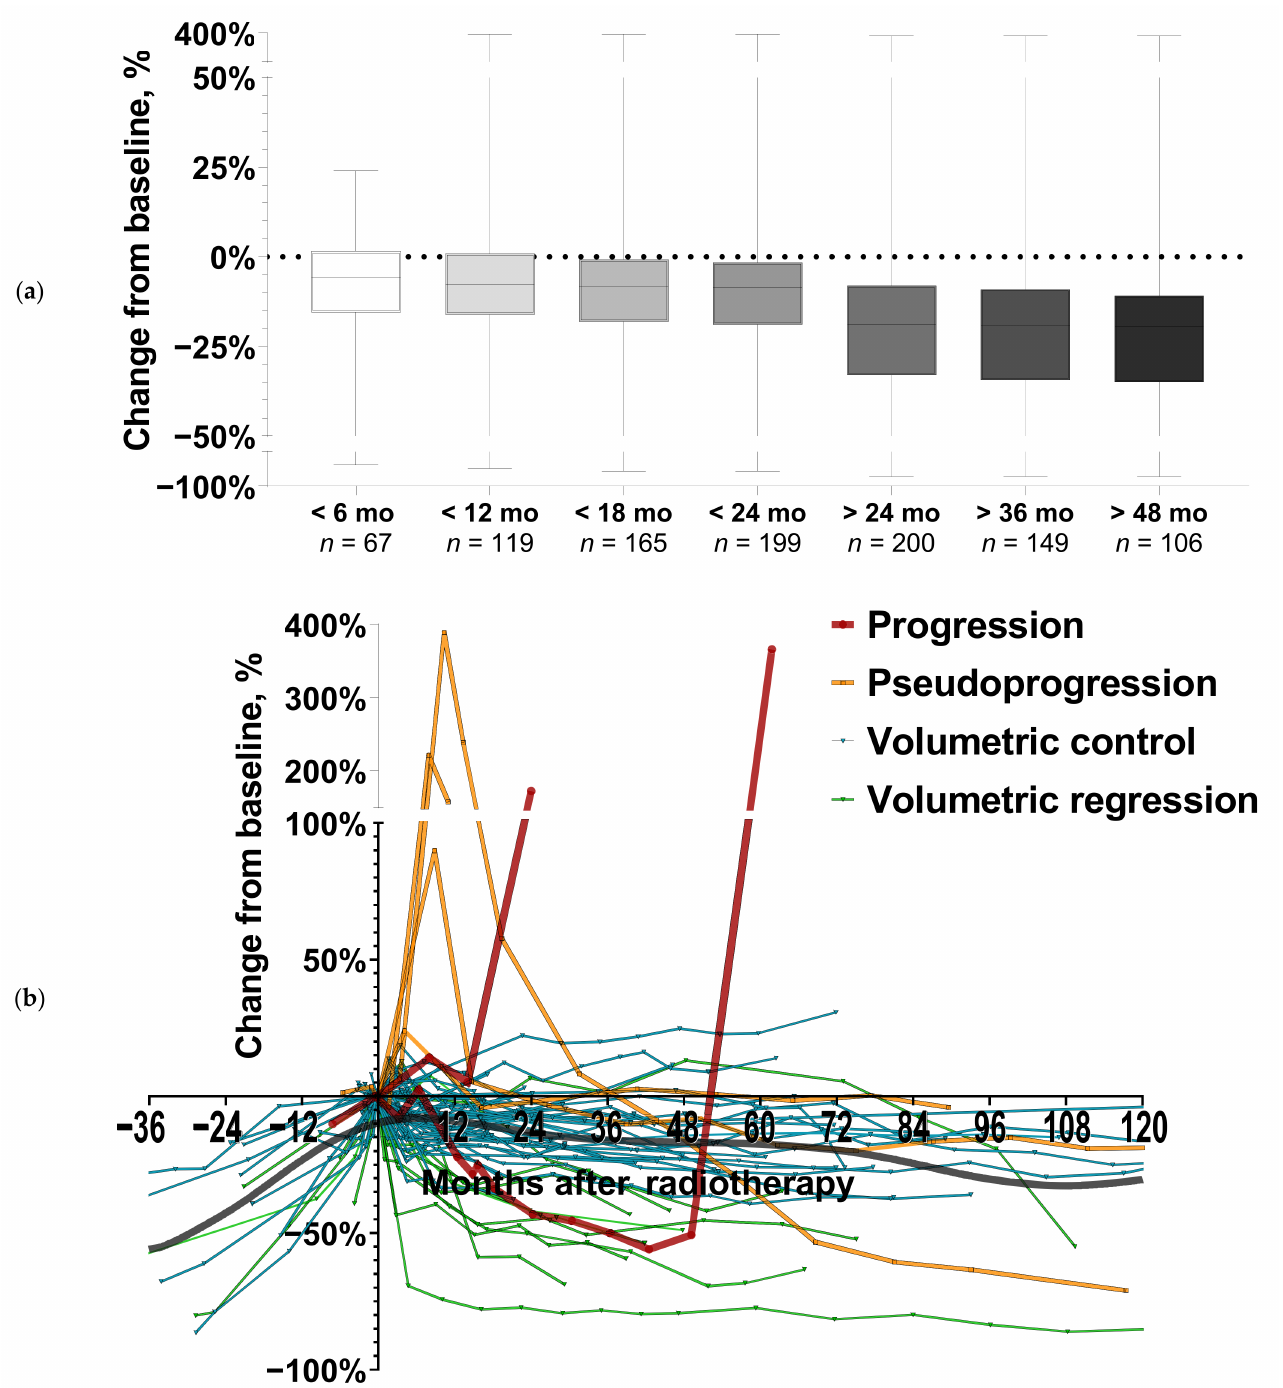
Figure 1. ( a ) Boxplot illustrating mean volumetric decrease over time following radiotherapy. Whiskers: minimum to maximum. ( b ) Spider plot illustrating tumor volume changes over time following radiotherapy (RT) for all cases. Dark red: cases with progression during post-RT follow- up; orange: transient enlargement/pseudoprogression; cyan: volumetric control; green: volumet- ric regression (i.e., minor and partial response according to volumetric RANO criteria). Local regression curve (dark gray line, LOWESS) indicates overall trend in volumetric changes following stereotactic